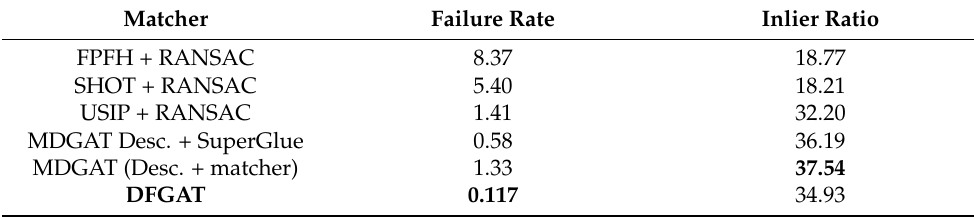
Table 2. Registration performance.